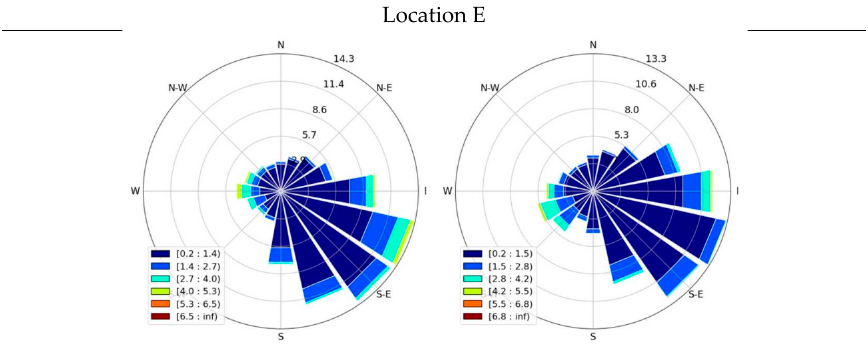
Figure 12. Wind roses for each studied location and year.